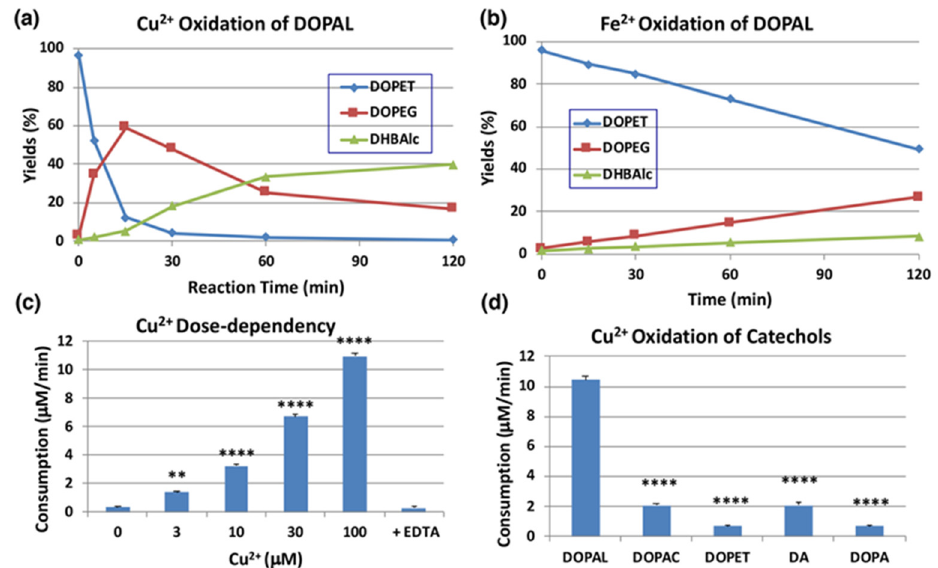
Figure 4. Time course of HPLC following of the metal-catalyzed oxidation of DOPAL (100 µM). ( a ) Cu 2+ (100 µM) at pH 7.4 and 37 °C. ( b ) Fe 2+ (100 µM) at pH 7.4 and 37 °C. Reaction was stopped by the addition of NaBH 4 followed by 0.8 M HClO4. Data were obtained from averages of two independent experiments ( a , b ). ( c ) Dose dependency of the effect of Cu 2+ ions. EDTA (200 µM) was added to Cu 2+ (100 µM). Reaction was stopped after 5-min reaction for 30 and 100 µM Cu 2+ , after 15-min for 10 µM Cu 2+ , and after 30-min for the rest. The consumption rates (µM/min) were calculated by dividing the consumption (µM) by the reaction time. ** p < 0.01 between 0 µM and 3 µM Cu 2+ and **** p < 0.0001 between 0 µM Cu 2+ and 10 to 100 µM Cu 2+ . ( d ) Comparison of reactivity among relevant catechols (100 µM) with Cu 2+ (100 µM). Reaction was stopped after 15 min (5 min for DOPAL) reaction at pH 7.4 and 37 °C by the addition of NaBH 4 followed by 0.8 M HClO4. **** p < 0.0001 between DOPAL and other catecholamines. Mean ± SEM from three independent experiments ( c , d ).